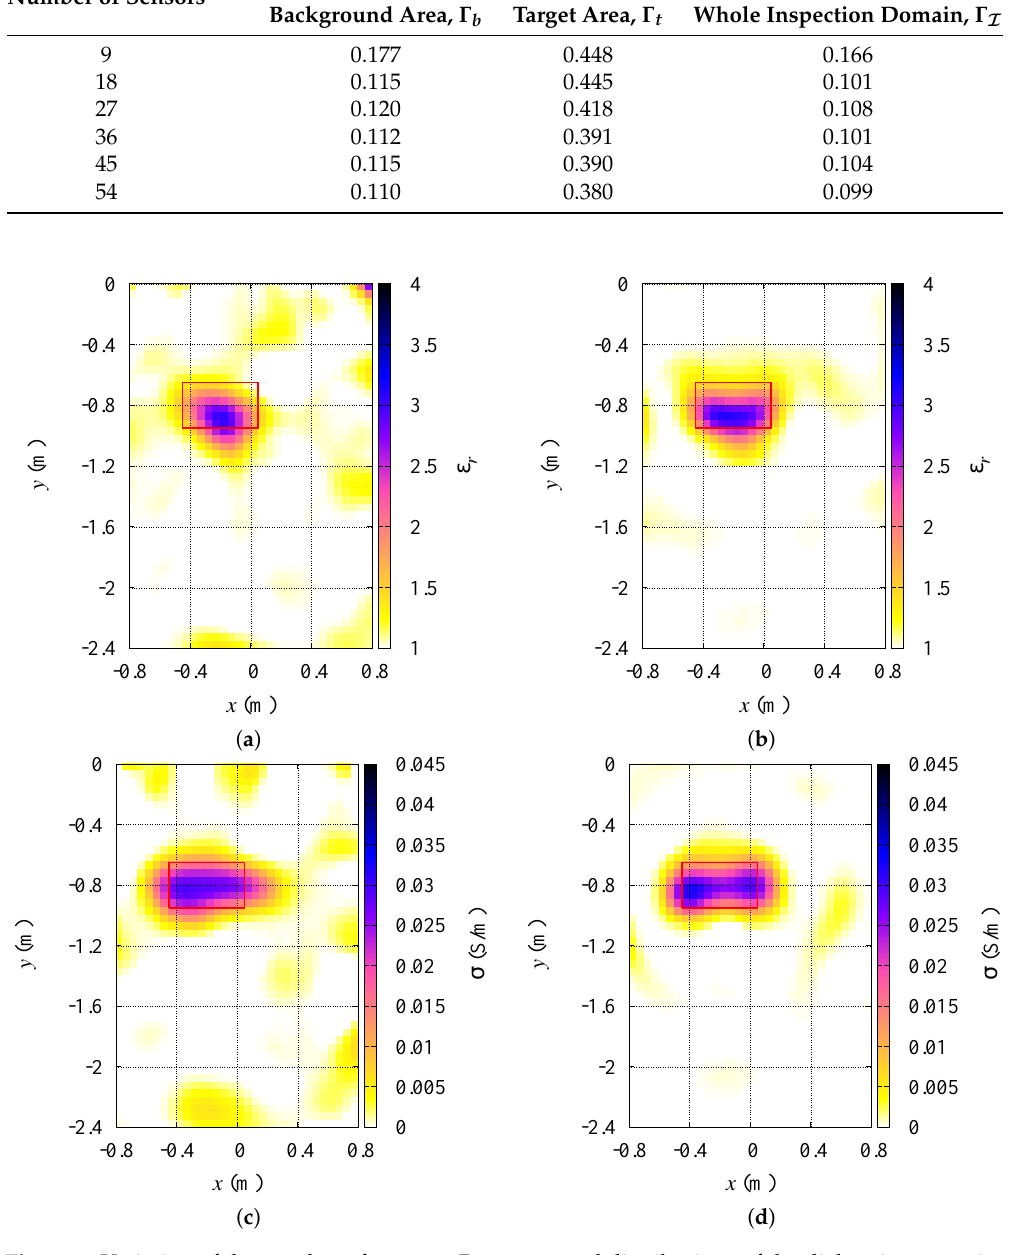
Figure 7. Variation of the number of sensors. Reconstructed distributions of the dielectric properties inside the investigation region: ( a ) relative dielectric permittivity, N = 9; ( b ) relative dielectric permittivity, N = 54; ( c ) electric conductivity, N = 9; ( d ) electric conductivity, N =